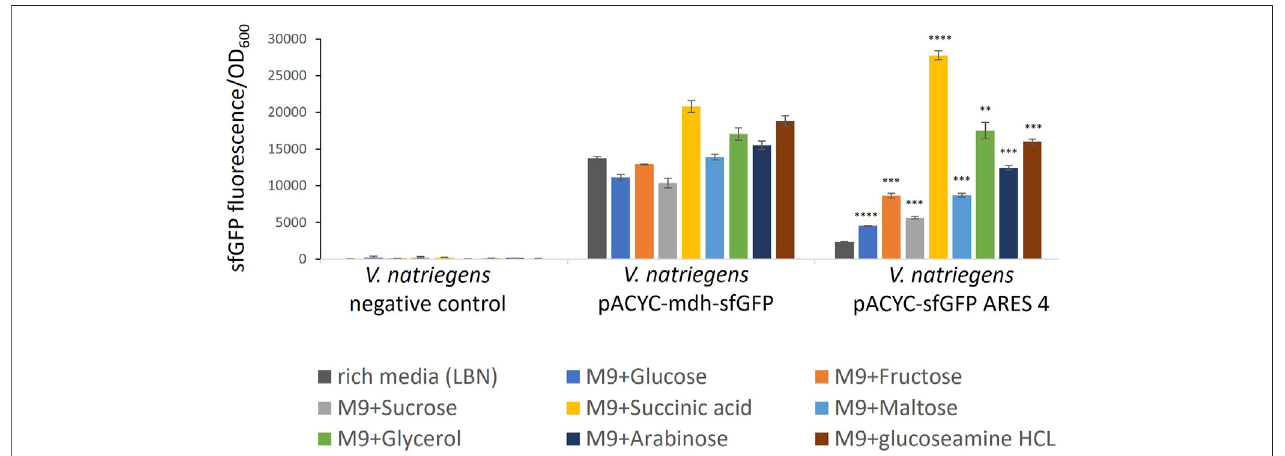
FIGURE 3 | Comparison of sfGFP FI of V. natriegens cultivated in M9N supplemented with different carbon sources as indicated by colour. The negative control exhibits negligible fl uorescence intensity. FI of the positive control and the clone carrying pACYC-sfGFP ARES 4 changes in a medium-dependent fashion. Error bars indicate the standard deviations calculated from three biological replicates. Asterisks indicate results of one-tailed T-tests, comparing FI measured in rich medium to minimal media of V. natriegens carrying pACYC-sfGFP ARES 4: * p -value < 0.05; ** p -value < 0.01; *** p -value < 0.001; **** p -value <